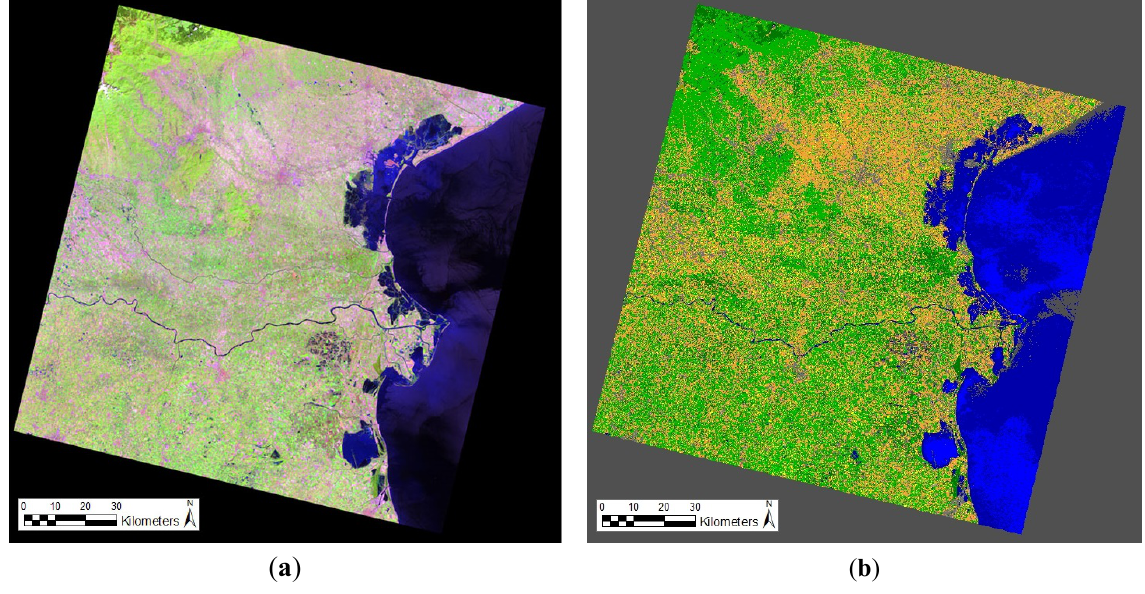
spectral categories. Map legend: refer to Table 2. Courtesy of Daniel Schläpfer, ReSe Applications Schläpfer. ( c ): SPOT-like SIAM™ (S-SIAM™) pre-classification map at coarse semantic granularity, 15 spectral categories. Map legend: generated from Table